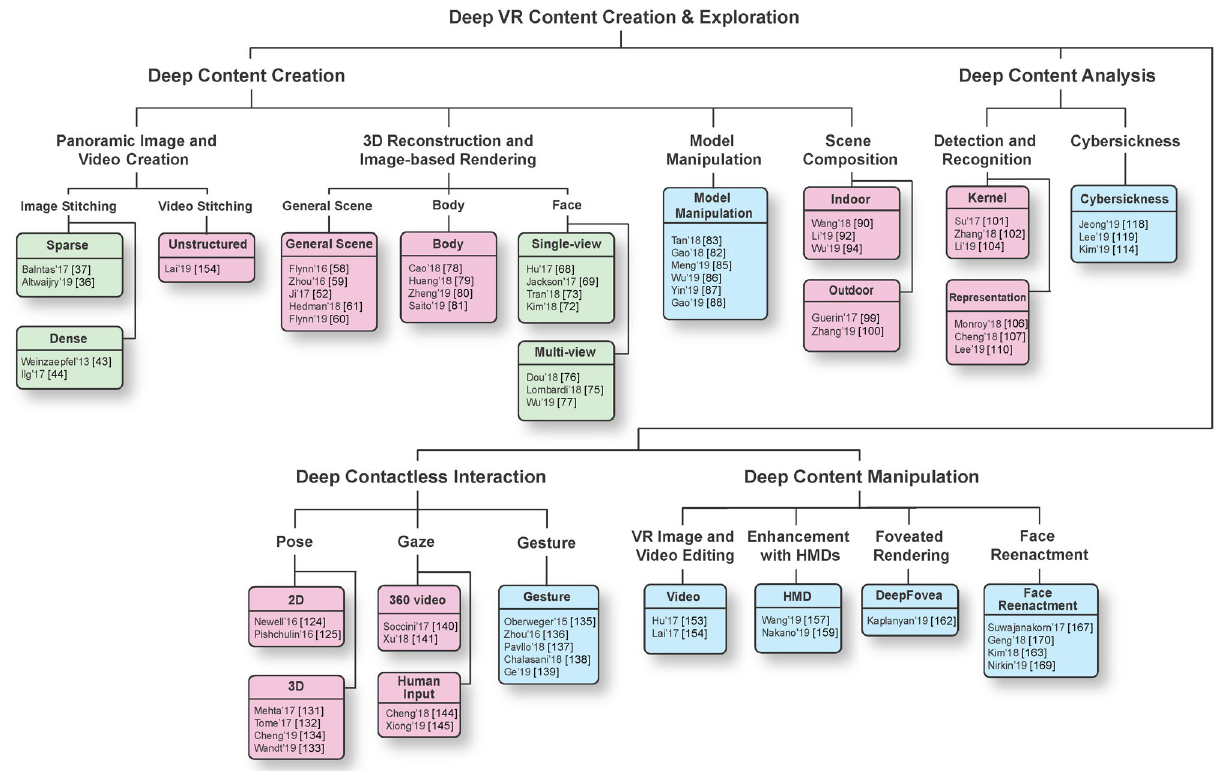
Fig. 1 Taxonomy of deep learning-based VR content creation and exploration techniques in this paper. Representative works are listed in colored